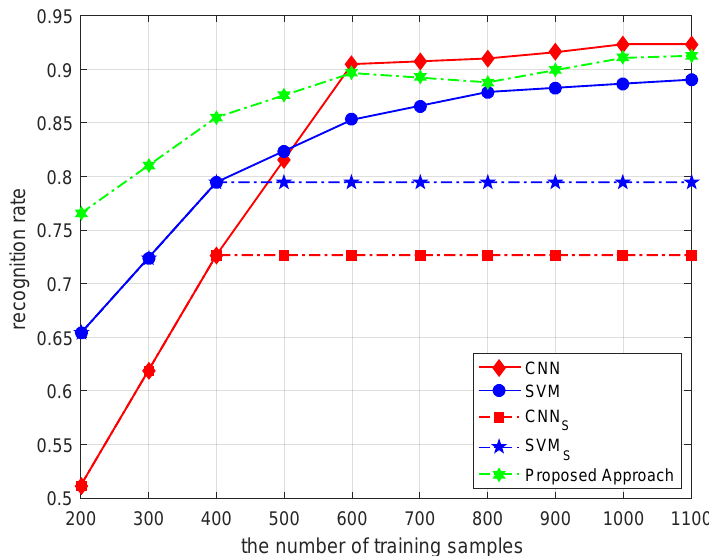
Figure 11. The recognition performance comparison results of different recognition models. The solid line indicates the recognition rate of different recognition models when the amount of SAR target samples is sufficient. The dotted line indicates the recognition rate of different recognition models when the ATR model solves the dilemma of a small sample set.